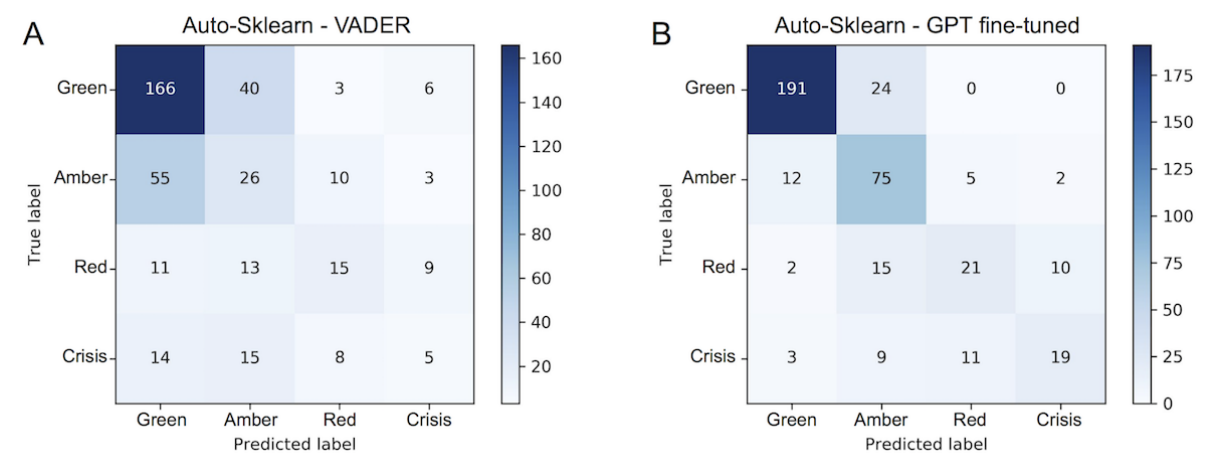
Figure 1. Confusion matrices for 2 models trained with Auto-Sklearn. Each cell in the matrix provides the counts of posts that were labeled in the corresponding row and column axis that represent the predicted and true labels, respectively. Counts are colored from the highest cell (blue) to the lowest (white). The top-left to bottom-right diagonal cells count correctly predicted posts. Panel A trained with Valence Aware Dictionary and sEntiment Reasoner (VADER) features. Panel B trained with features from a fine-tuned Generative Pretrained Transformer (GPT) language